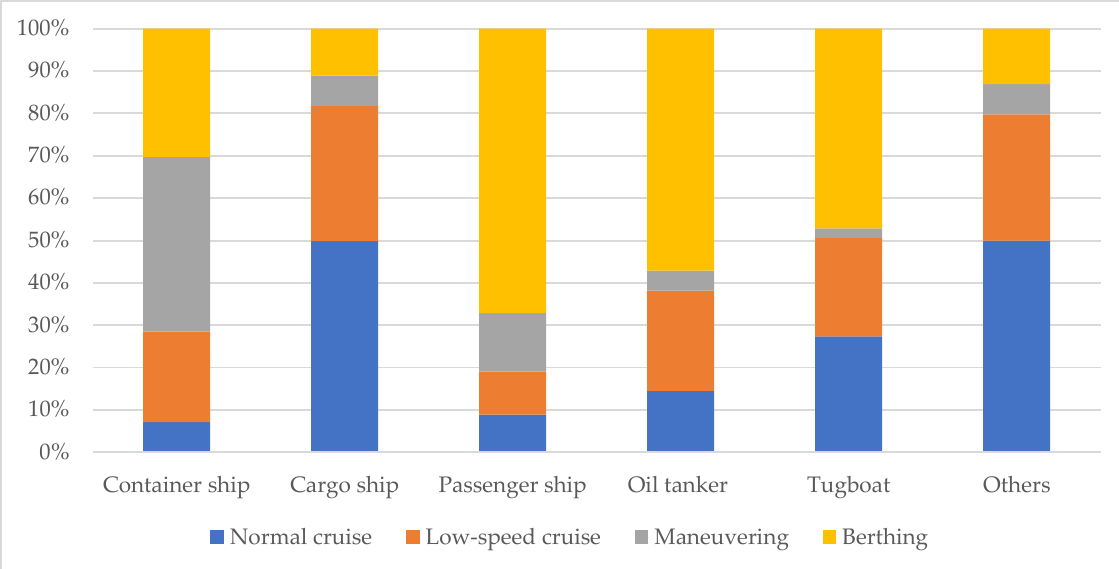
Figure 11. Comparison of C X H X emissions in different sailing states.